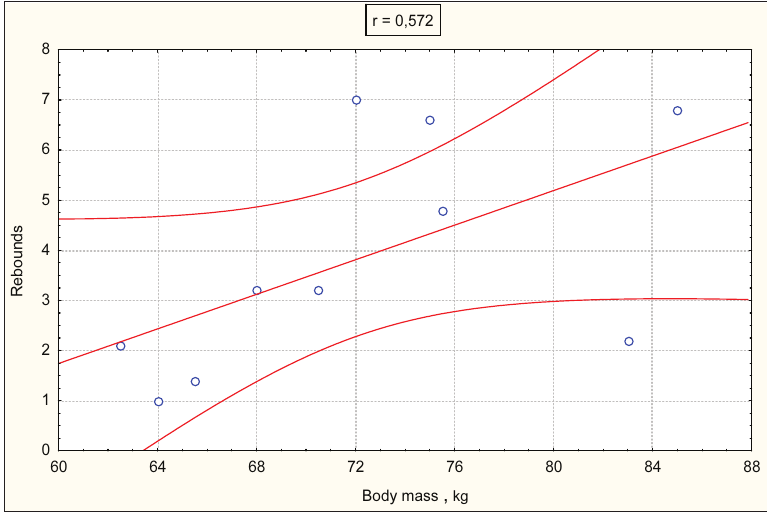
Figure 1. The correlation of body mass with rebounds